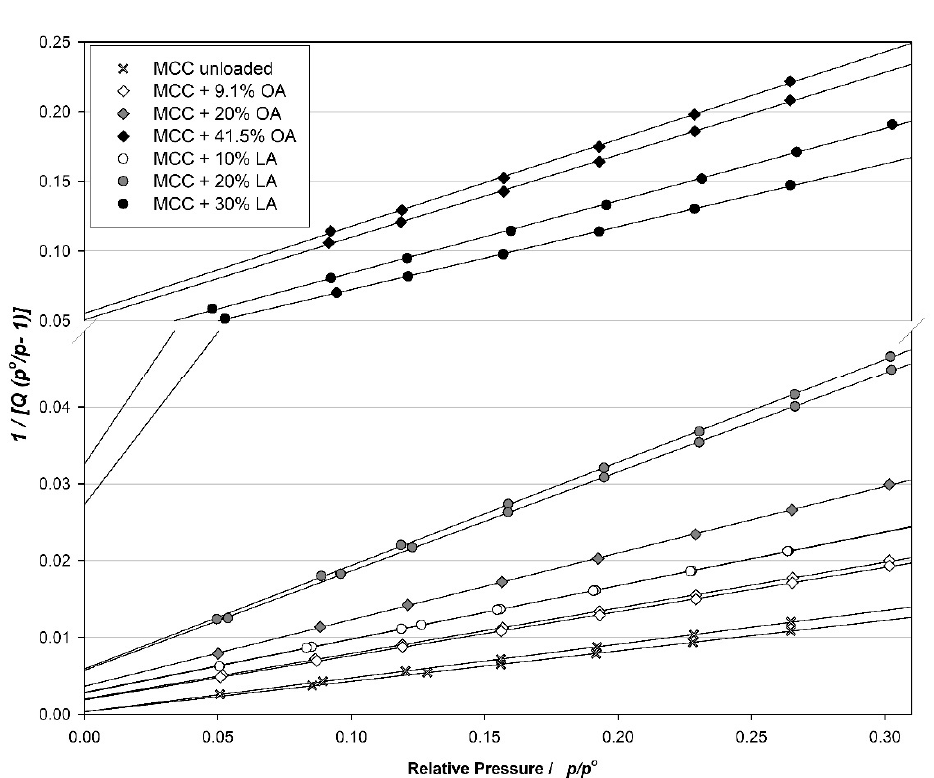
Figure A1. BET Surface area plots of loaded and unloaded modified calcium carbonates (MCC) (n = 2, Q = N 2 amount adsorbed m 3 g − 1 ).